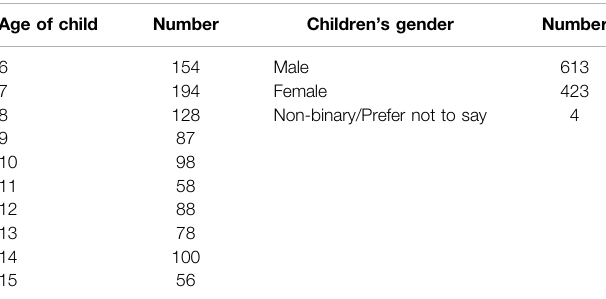
TABLE 2 | Age and gender distribution of the children being considered in the